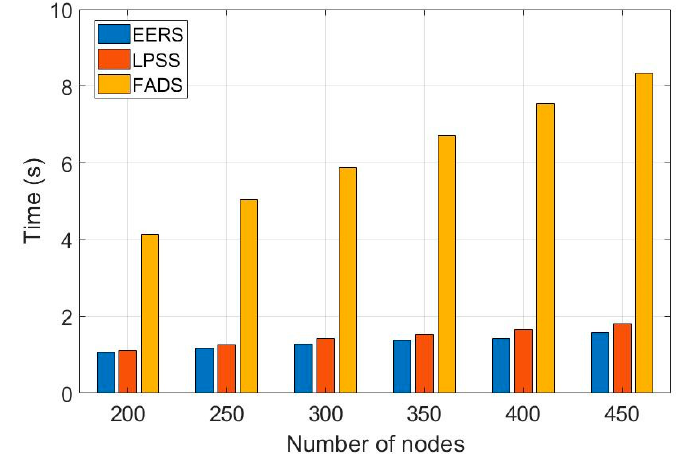
Sensors 2020 , 18 , x FOR PEER REVIEW Figure 8. Required time for reference node scheduling process (r = 85 m, N = 200: 450). Figure 8 . Required time for reference node scheduling process (r = 85 m, N = 200: 450). Figure 8 . Required time for reference node scheduling process (r = 85 m, N = 200: 450).